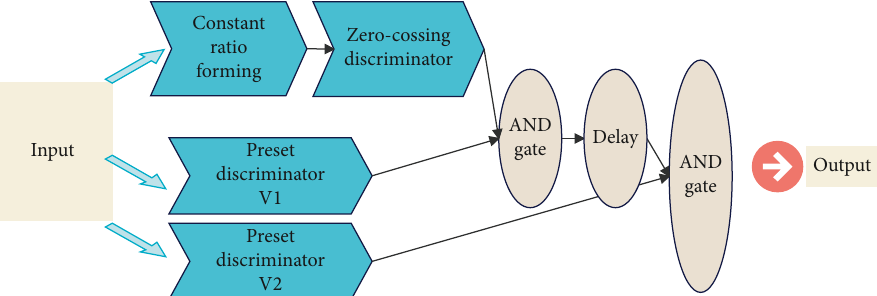
Figure 6: Schematic diagram of ARC timing.